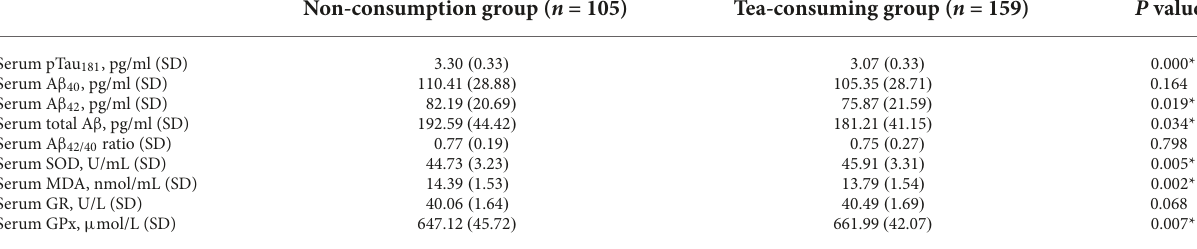
TABLE 6 The biomarker differences between non-consuming group and tea-consuming group.